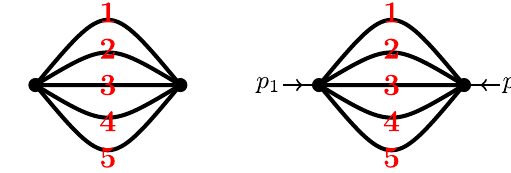
Fig. 1 Four-loop sunrise diagrams with and without the insertion of external momenta in the vertices